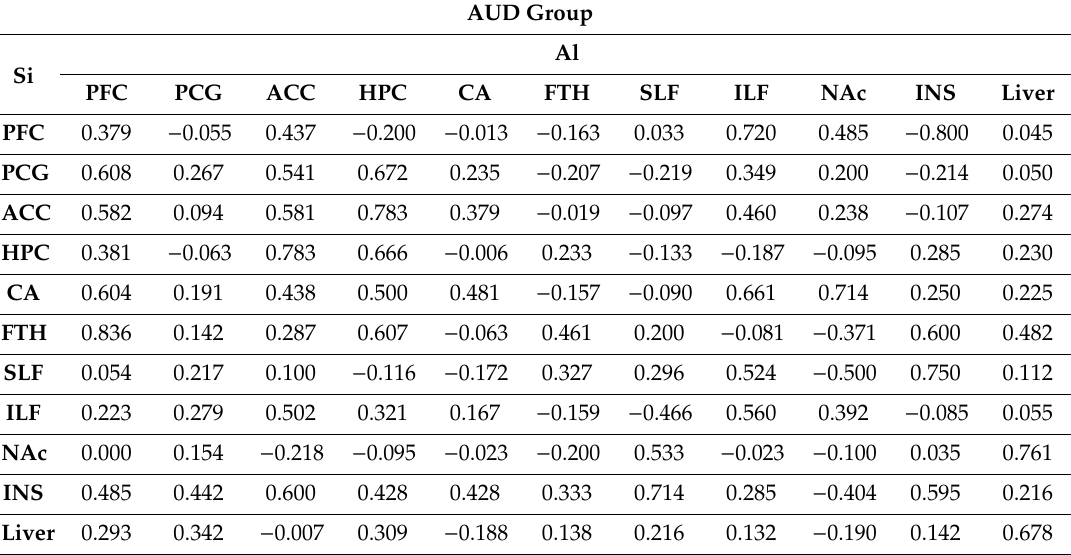
Table 7. Spearman correlation coe ffi cient calculated for Al and Si content in di ff erent brain regions of AUD